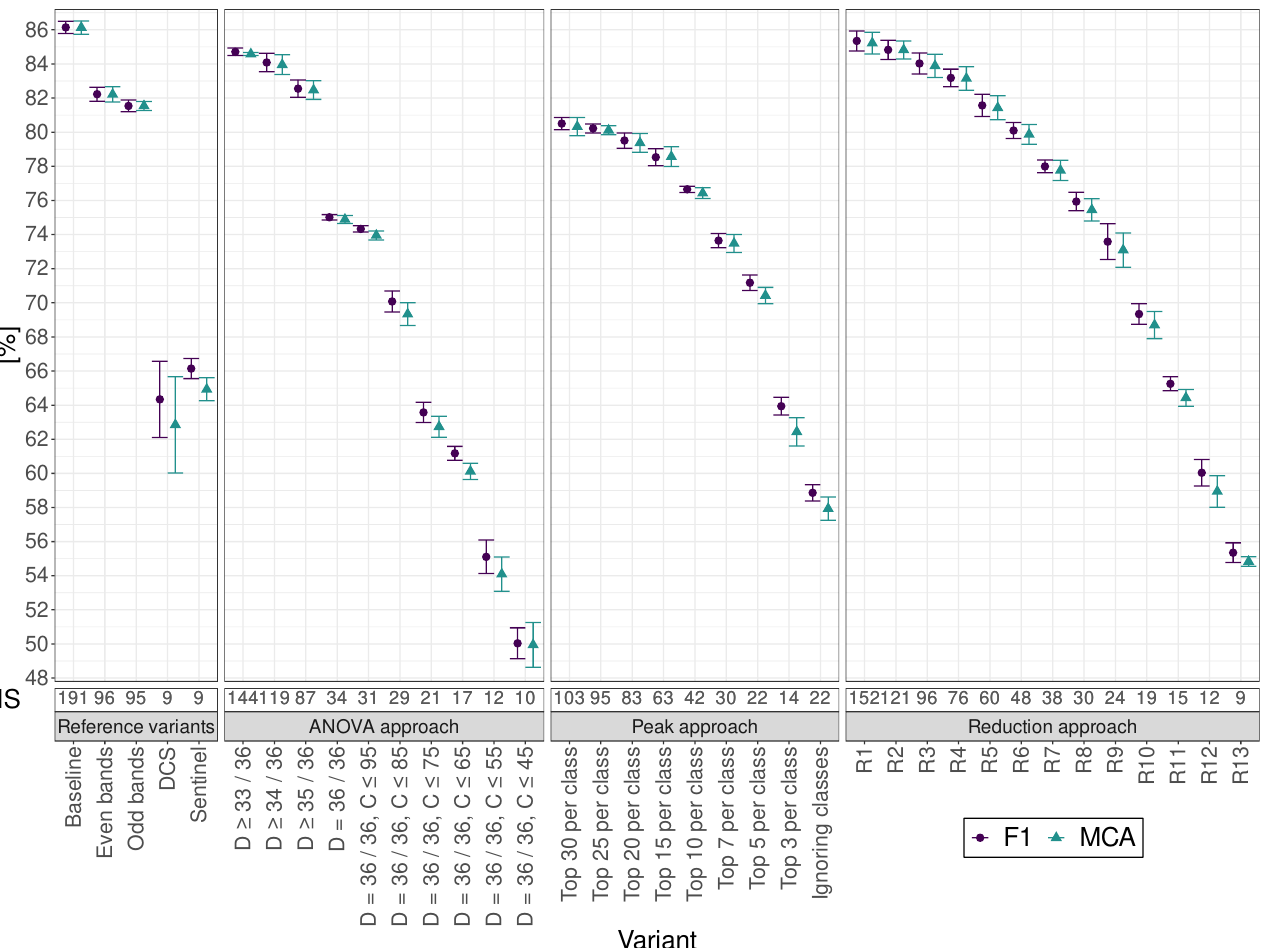
Figure 3. Mean classification accuracy (MCA) and weighted F1 score (F1) for each variant in the respective approaches. IS denotes the input size. Measures are shown with a slight x -axis offset for better visualization. Error bars indicate standard deviation, five-fold